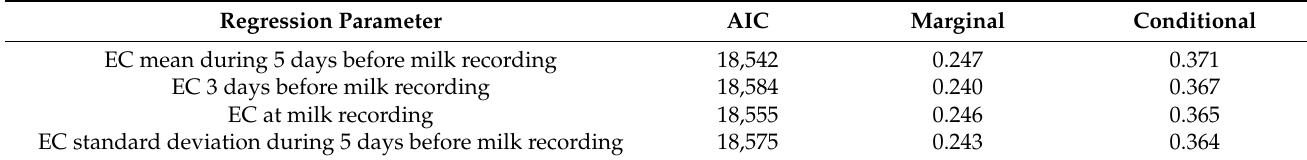
Table 6. AIC (Akaike information criterion), marginal and conditional R2 from models used to investigate the relationship between milk conductivity and SCS at